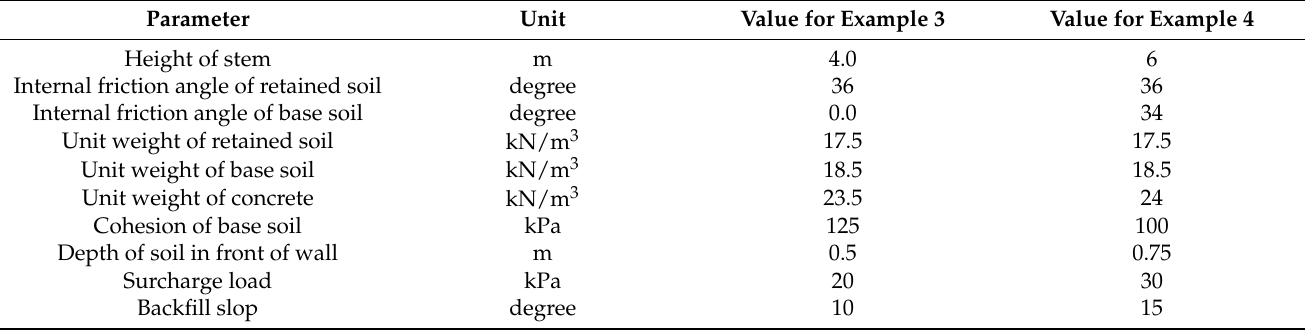
Table 17. Input parameters for design examples 3 and